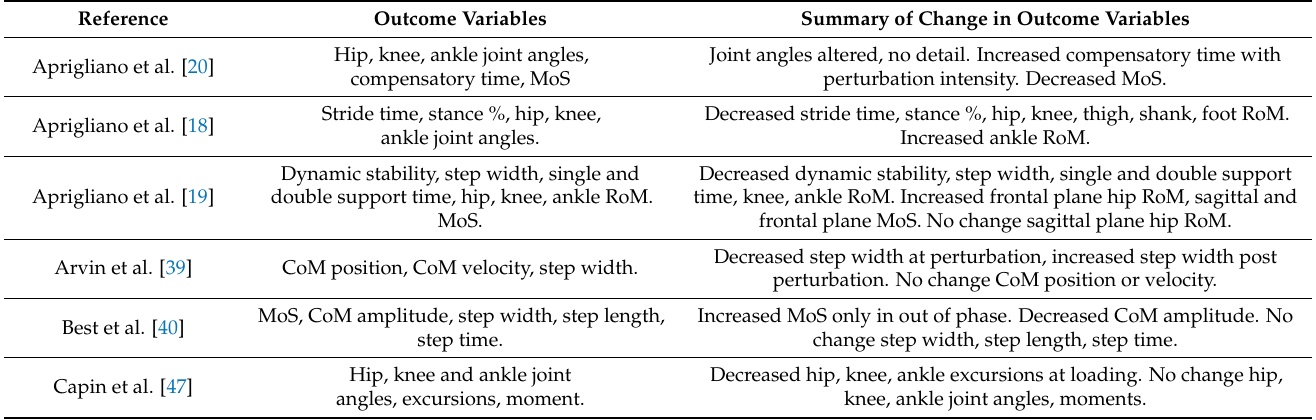
Table 3. Outcome measures and the perturbation